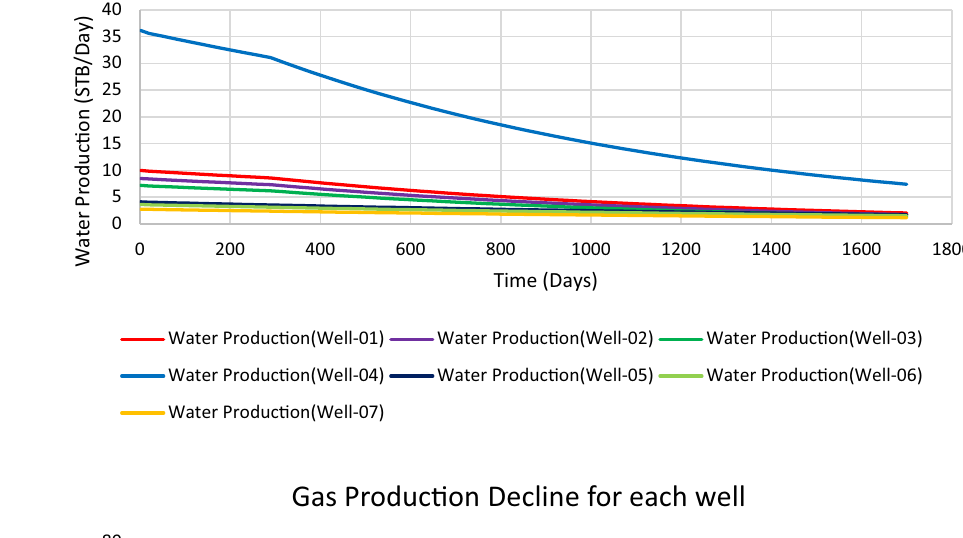
Fig. 6 Water production rate for each well